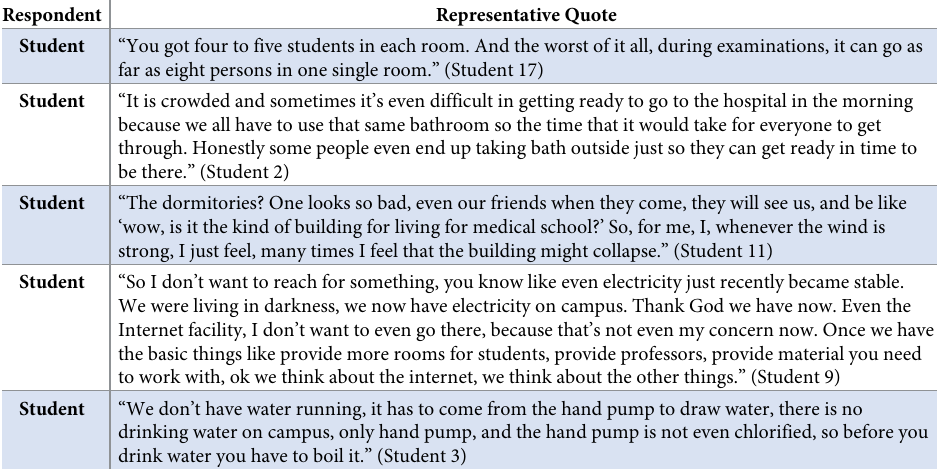
Table 4. AMD students’ experiences with medical school infrastructure (2016).